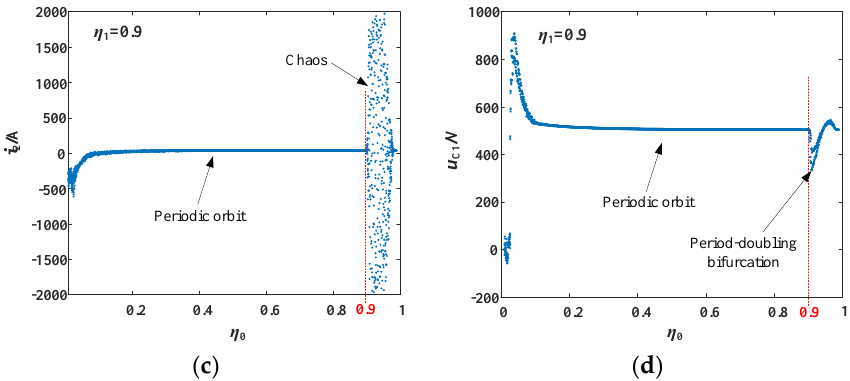
Figure 8. Bifurcation diagrams with η 0 as the bifurcation parameter. ( a ) Bifurcation diagram of the output current 𝑖 2 at η 1 = 0.5 ; ( b ) Bifurcation diagram of the output voltage 𝑢 C1 of the photovoltaic array at η 1 = 0.5 ; ( c ) Bifurcation diagram of the output current 𝑖 2 at η 1 = 0.9 ; ( d ) Bifurcation diagram of the output voltage 𝑢 C1 of the photovoltaic array at η 1 = 0.9 .